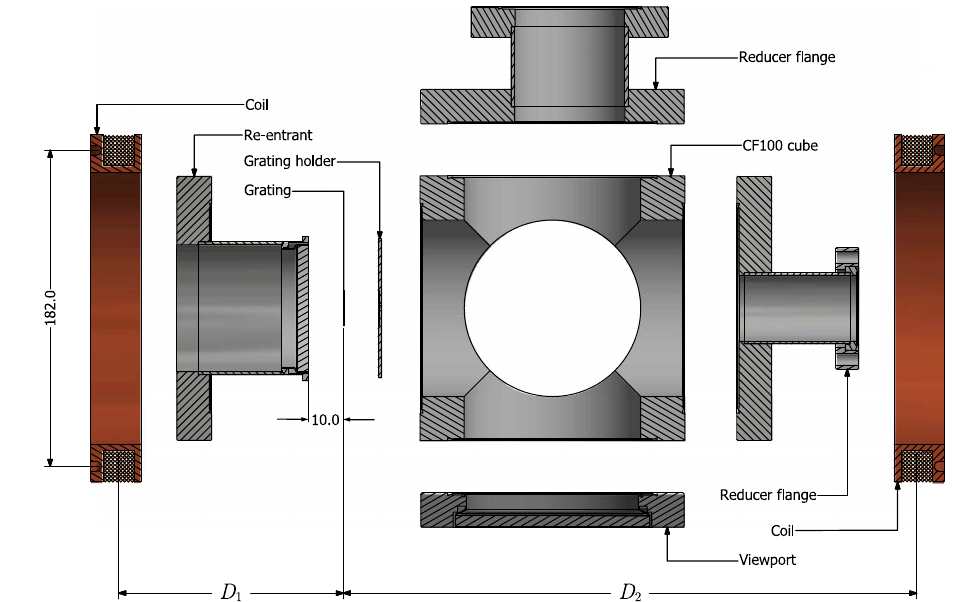
FIG. 3. Cross section of the experimental setup. The grating is fixed in a holder which is connected to the reentrant flange using 10 mm spacers. The two coils generate the magnetic quadrupole field with D 1 and D 2 the distance from the coils to the grating